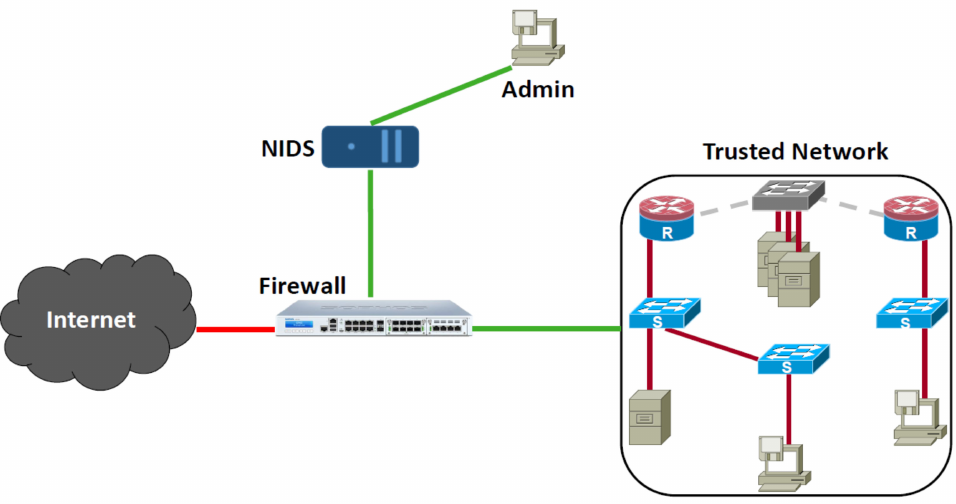
Figure 1. NIDS typical deployment in computer